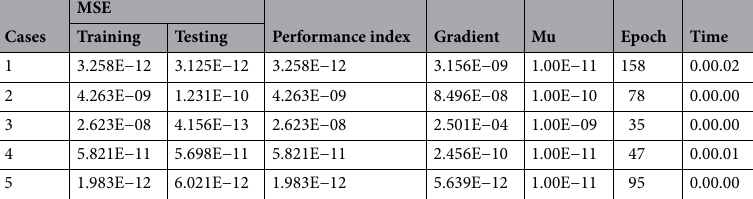
Table 7. Scenario 5: variation of ws .